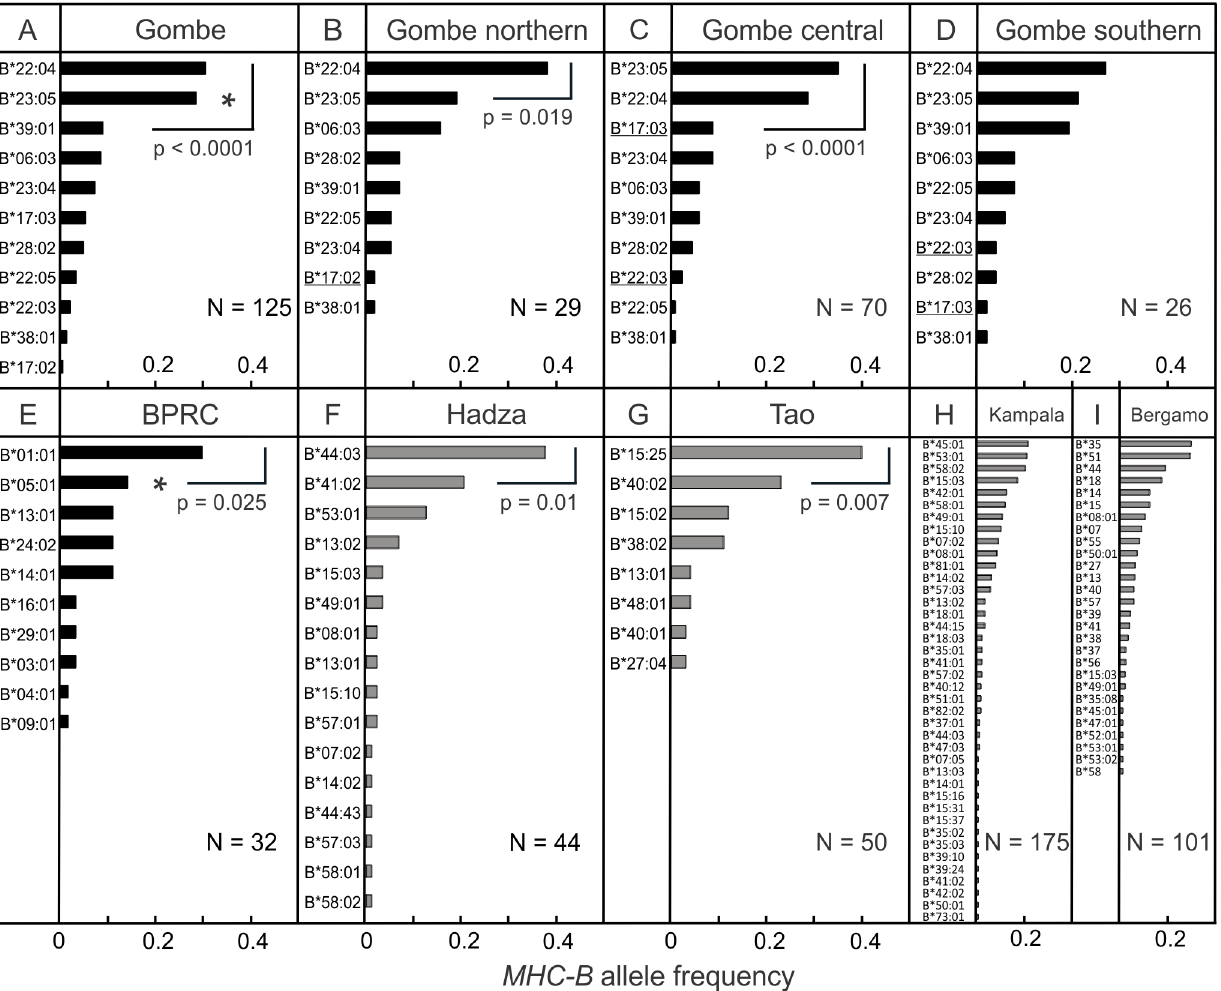
Fig 3. Frequency distribution of MHC-B alleles in chimpanzee and human populations. The upper panels give the Patr-B allele frequencies for the entire Gombe population (A), the northern community (B), the central community (C), and the southern community (D). The Gombe chimpanzees are of subspecies P. t. schweinfurthii . (B-D) Underlined are the names of alleles not present in all three communities. The lower panels show the Patr-B allele frequencies for the Biomedical Primate Research Centre (BPRC) chimpanzee population, subspecies P. t. verus [41] (E) (further described in S1 Text), and the HLA-B allele frequencies (in gray) in the Hadza [42] (F), Tao [43] (G), Kampala [43,44] (H), and Bergamo [43] (I) human populations. The Hadza and Tao are indigenous, tribal populations from Africa (Tanzania) and Asia (Taiwan), respectively; Kampala and Bergamo are admixed urban populations from Africa (Kampala, Uganda) and Europe (Bergamo, Italy), respectively. The wider brackets (A and C) show that the two most common alleles are significantly more frequent than all other alleles, but do not differ significantly from each other; the narrower brackets (B, E, F, and G) show that the most common allele is significantly more frequent than the second most common allele (Fisher ’ s Exact tests, p -values given below the bracket ( p < 0.0001 applies to both higher frequency alleles in A and C)). The asterisk (E) indicates that the second most common alleles, in Gombe and BPRC, have significantly different frequencies (Fisher ’ s Exact test, p = 0.033). Overall, the Patr-B frequency distributions for Gombe and BPRC do not differ significantly ( χ 2 test) (In this analysis, the frequencies of the two rarest Gombe alleles were combined so as to give equal allele numbers for the two populations). The HLA-B distributions of the indigenous human populations do not differ significantly from the Patr-B distributions of the chimpanzee populations. The HLA-B distributions in urban human populations do differ significantly ( χ 2 tests, p < 0.01) from the Patr-B distributions of the chimpanzee populations (In this analysis, only the three most common alleles were included individually; all other alleles were combined to equalize the number of alleles for the different populations). N: the number of individuals analyzed. Data for this figure are provided in S1 Data.